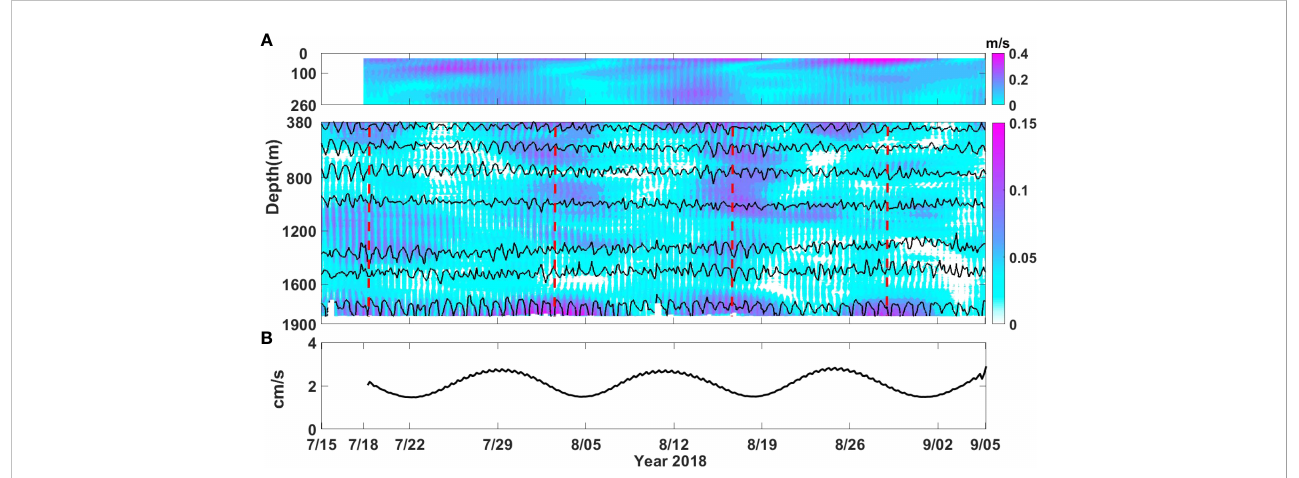
FIGURE 3 (A) Time-depth maps of diurnal current variances ( u 2 + v 2 ) 1/2 (colors) at M1. Black contours are isotherms of 2.4, 2.7, 3.0, 4.5, 6.0, 7.5 and 9.0°C. (B) The diurnal ( K 1 + O 1 ) barotropic tides current